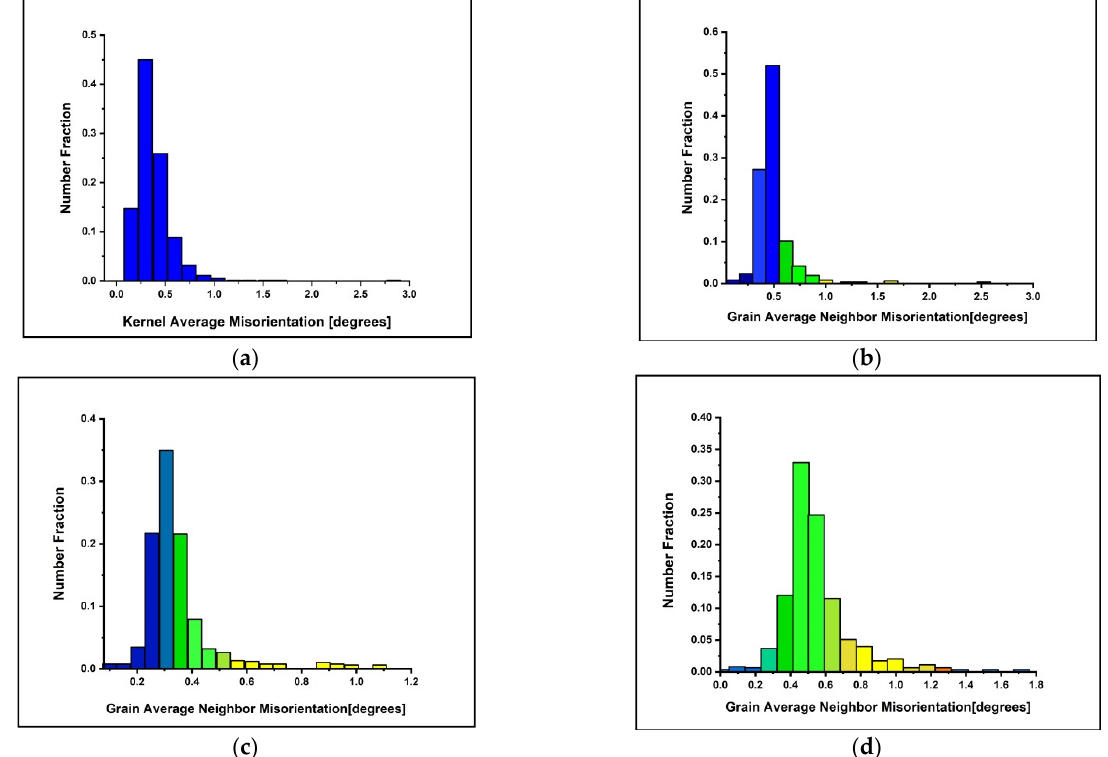
Figure 5. Frequency histograms of grain boundary misorientation of the ECAPed sample after ( a ) no pass, ( b ) first pass, ( c ) second pass, ( d ) third pass at ambient